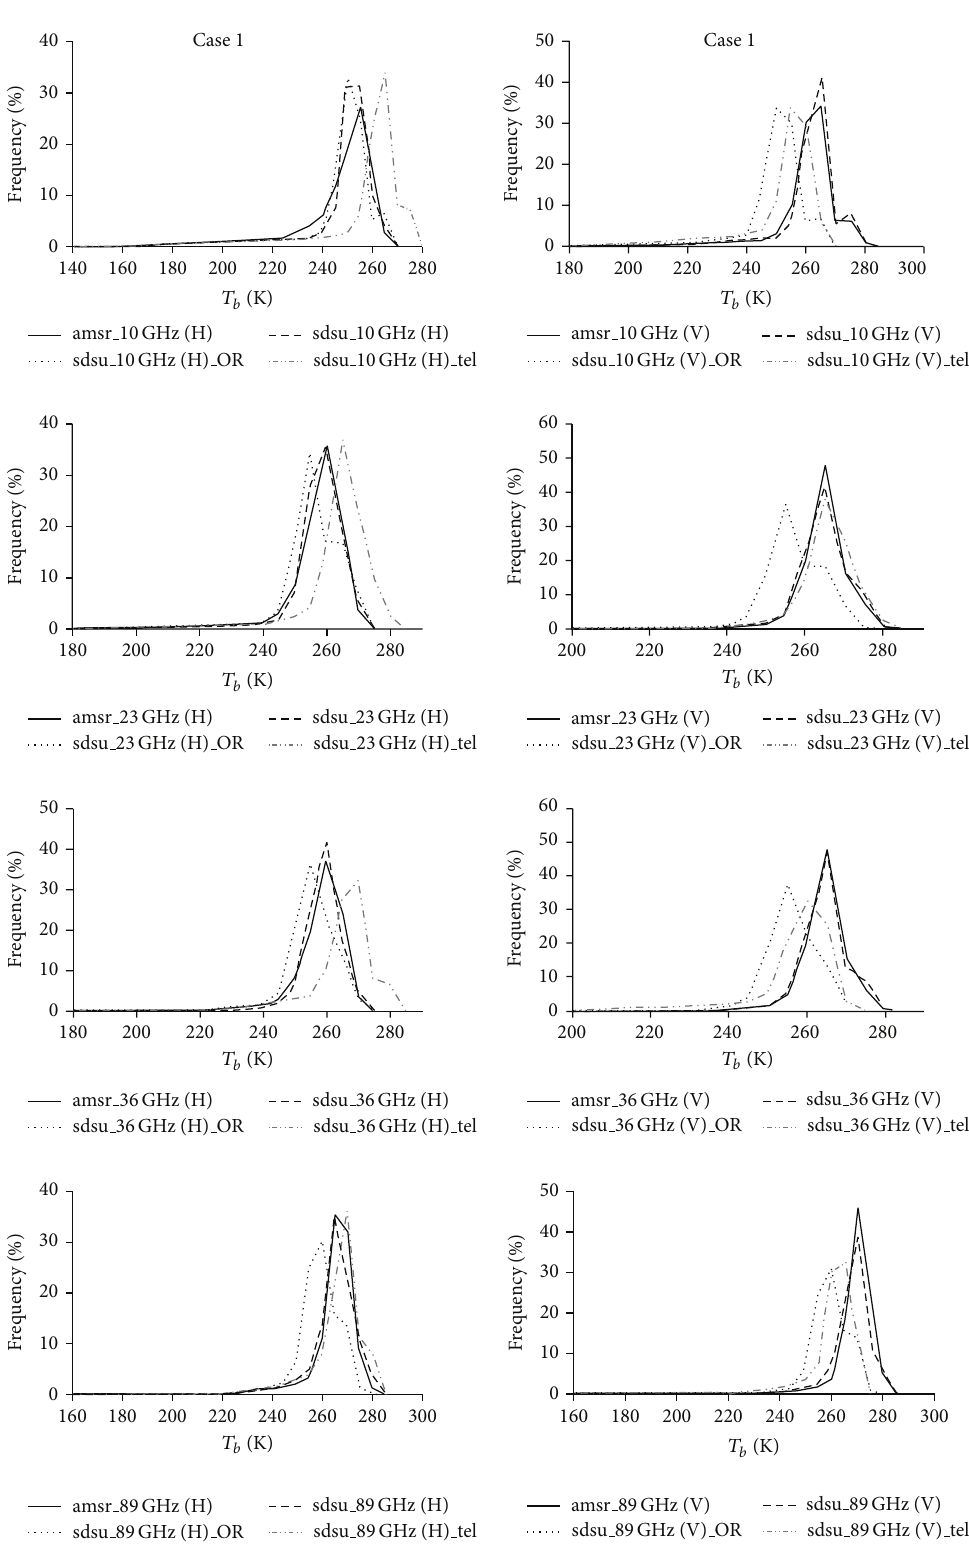
Figure 5: Results for December 18, 2010. Frequency distribution of 𝑇 𝑏 ’s of land pixels for all 8 channels, for AMSR-E (solid line), the original version of SDSU (dotted line-noted as OR) the new emissivity version (dashed line), and TELSEM based simulations (dot-dashed grey line noted as